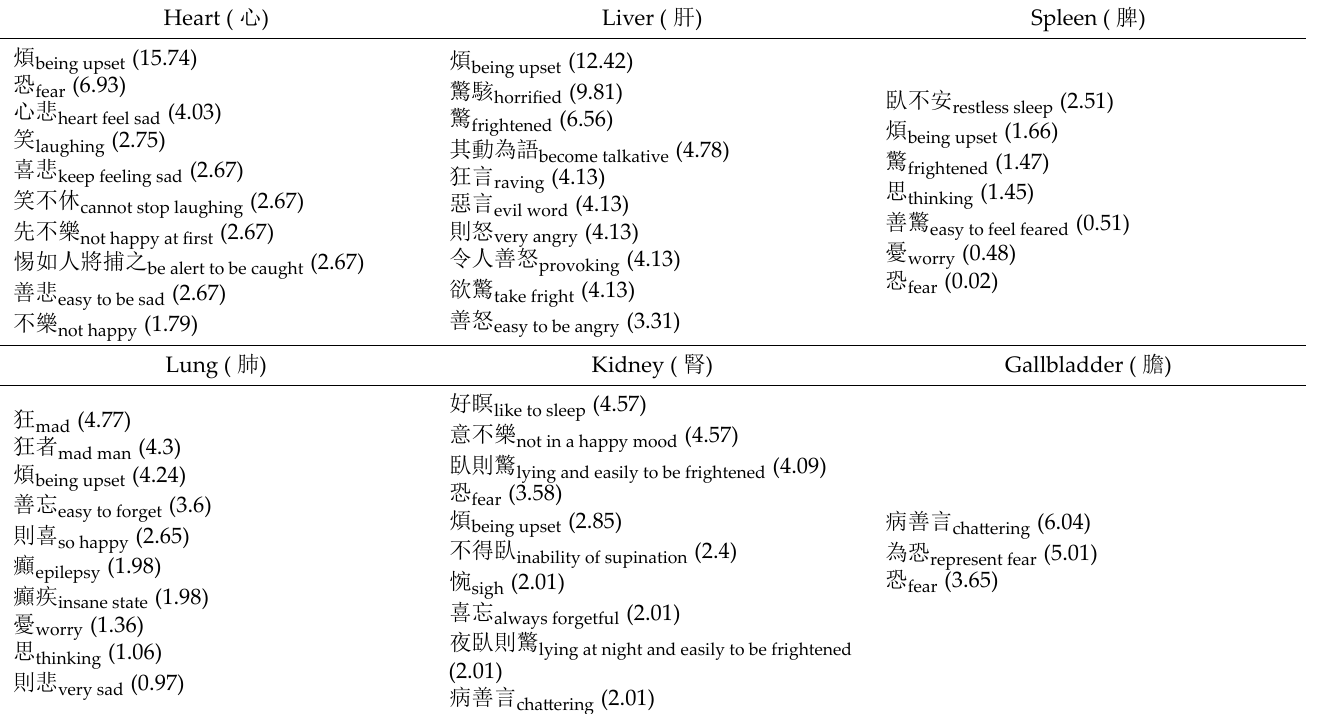
Table 2. Characteristics of the relationships between the five depots and two palaces and top 10 mental disorders